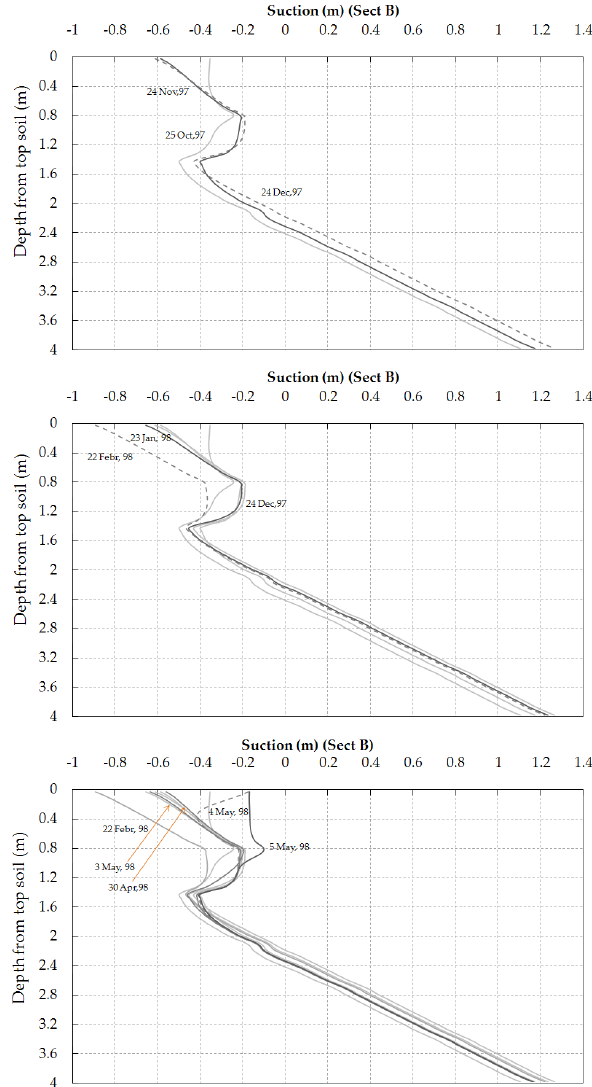
Figure 10. Computed suction profile for downslope section (Section B).